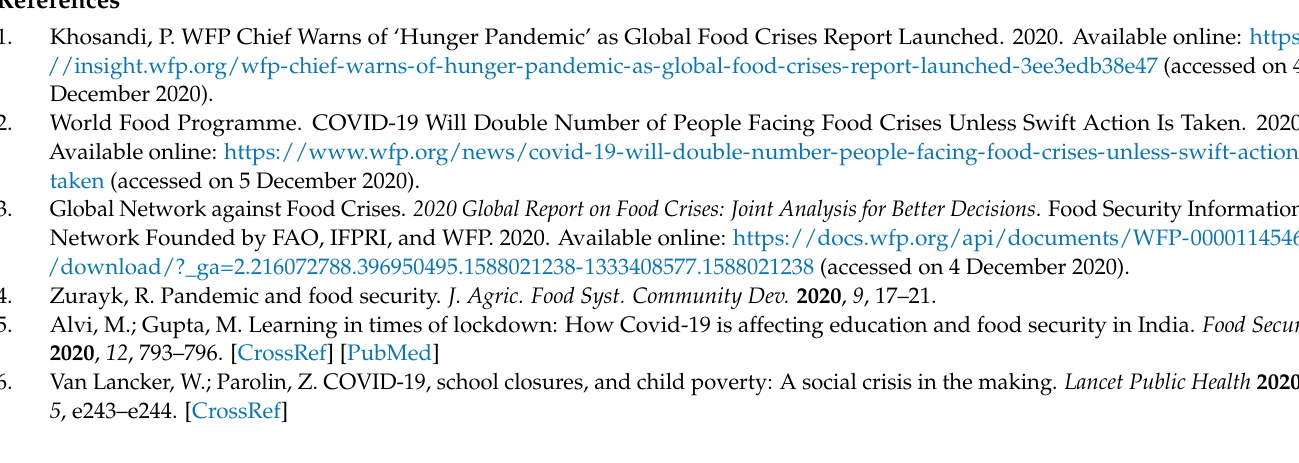
review, Table S2: List of details extracted on food security interventions in the context of the COVID- 19 pandemic, Table S3. Characteristics of food security interventions implemented in response to the COVID-19 pandemic by INGOs and UN agencies in low-and-middle income countries from